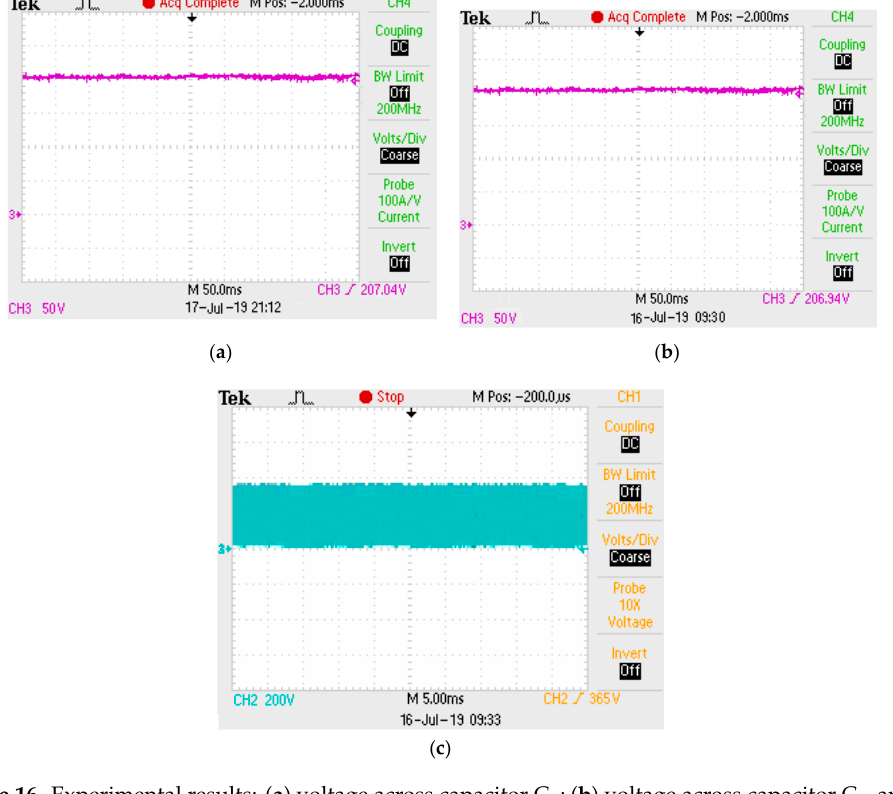
Figure 16. Experimental results: (a) voltage across capacitor C 1 ; (b) voltage across capacitor C 2; and (c) DC-link voltage of unified power quality conditioner.